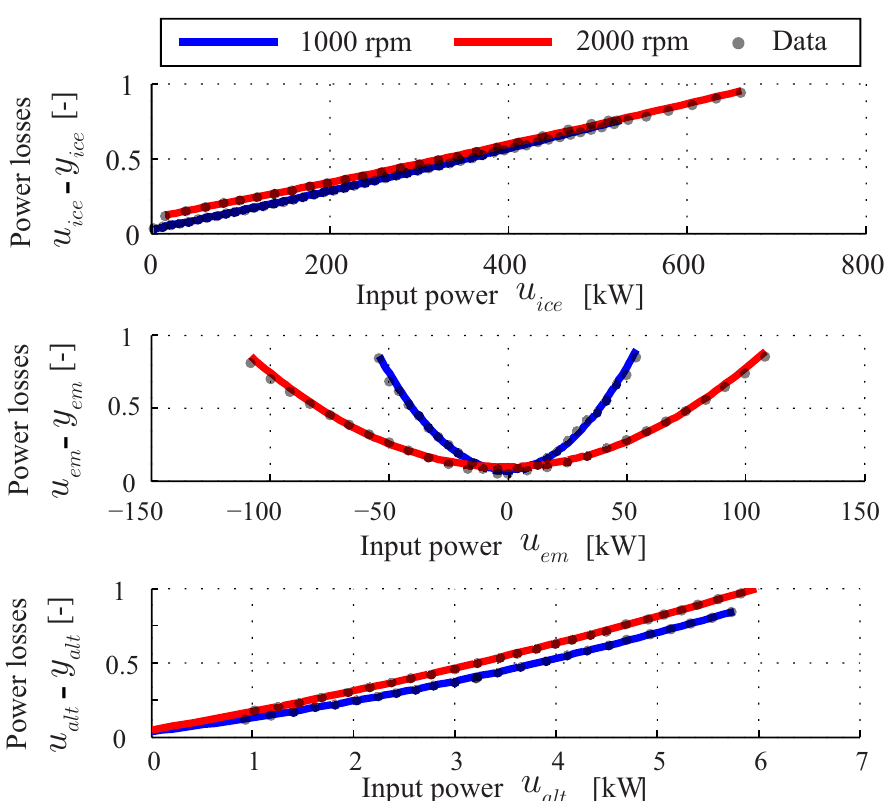
Figure 2. Power losses of the internal combustion engine, the electric machine and the alternator for two different engine